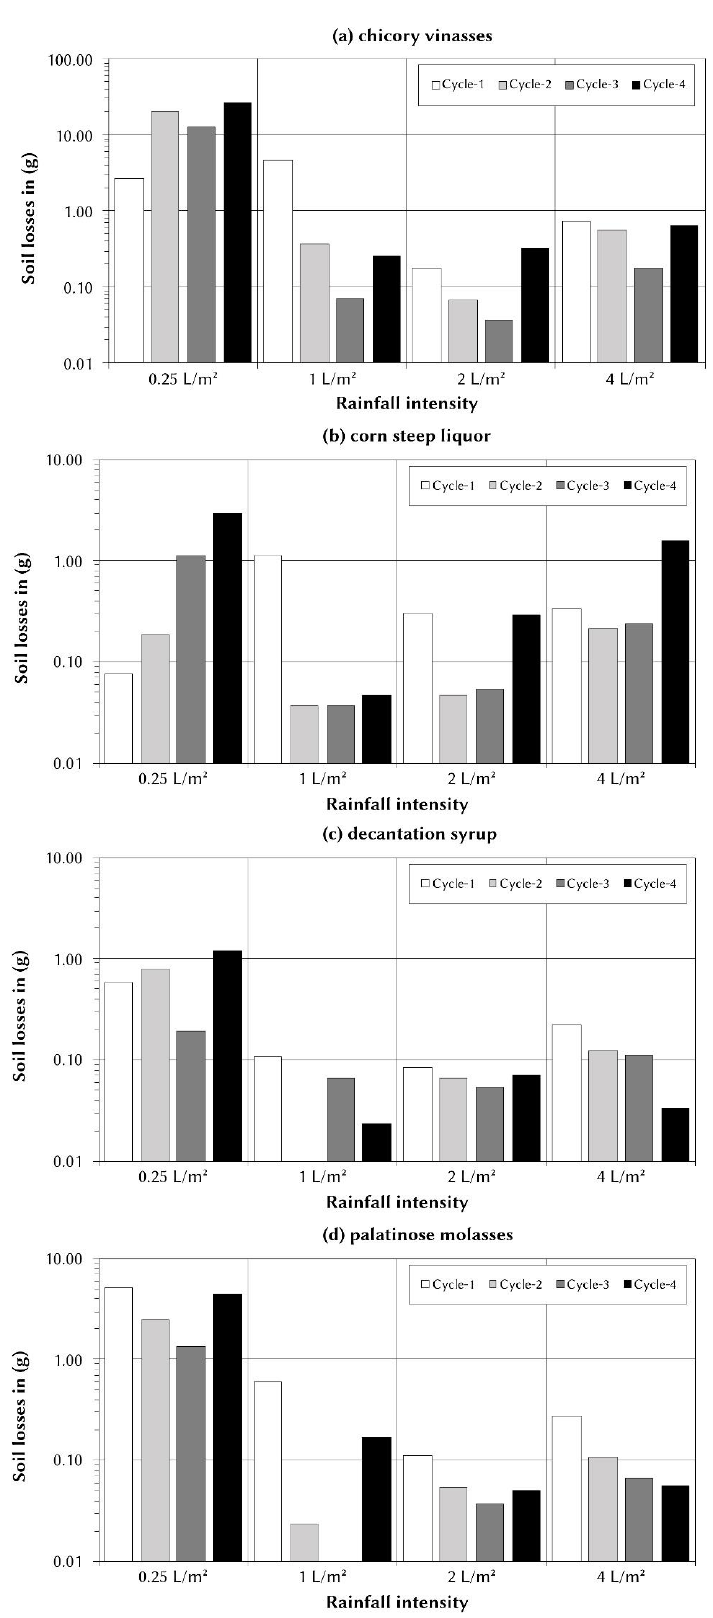
Figure 5. Effect of wet – dry cycles on wind-induced soil losses (g) from mine soils treated with dif- ferent food processing by-products (mean values, n = 3): ( a ) chicory vinasses, ( b ) corn steep liquor, ( c ) decantation syrup, and ( d ) palatinose molasses. ( c ) decantation syrup, and ( d ) palatinose